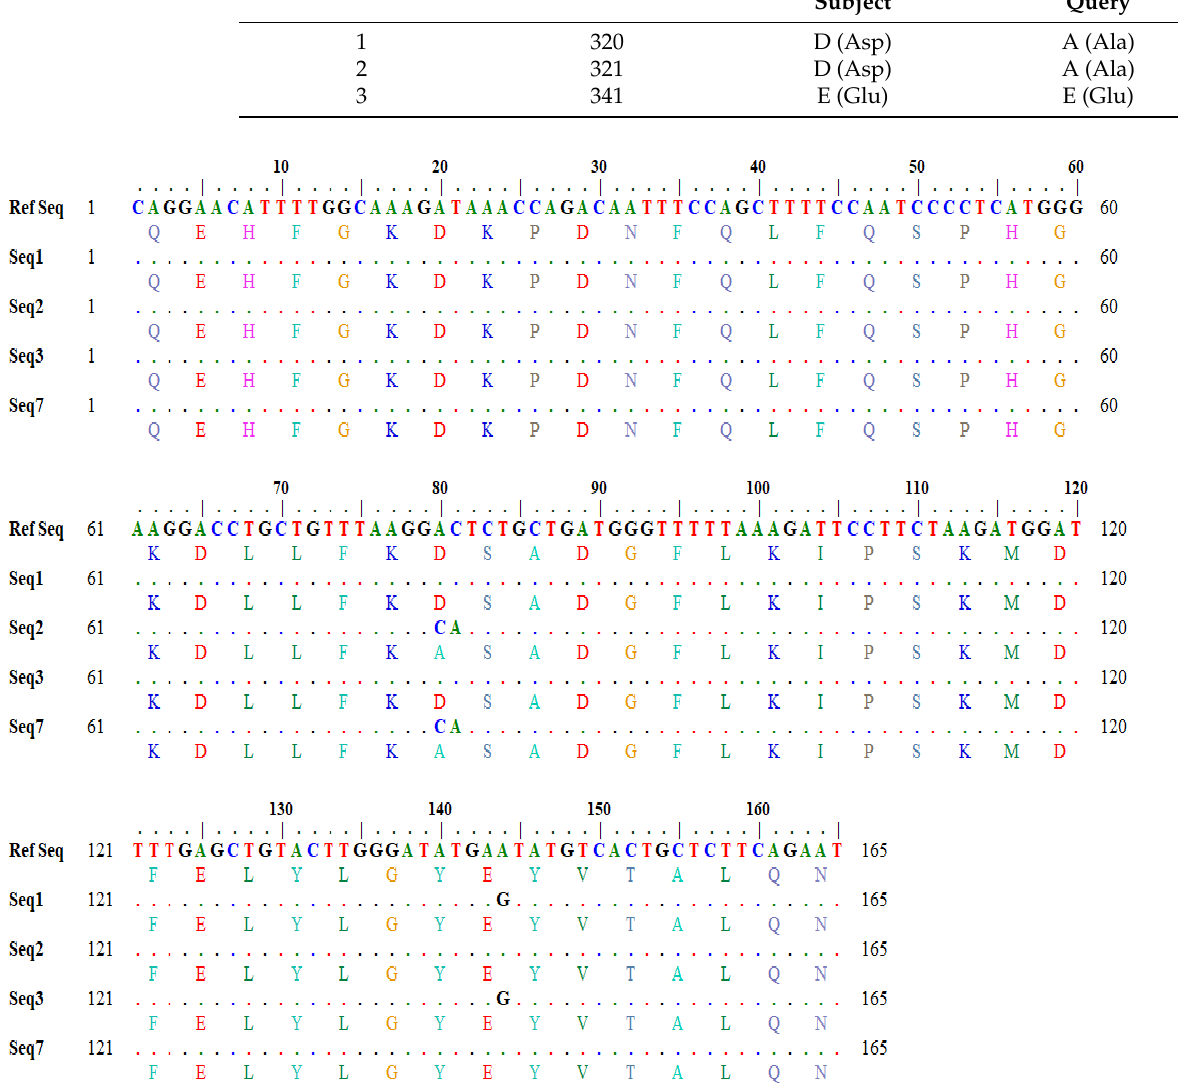
Figure 3. Detailed output of one-letter translation product showing amino acid variations. Table 8. Submission of nucleotide sequences with SNPs to the NCBI